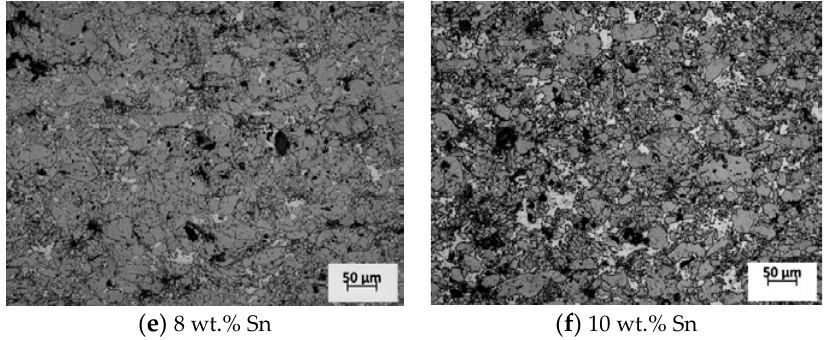
Figure 3. Microstructures of matrix of sintered samples with different Sn contents.